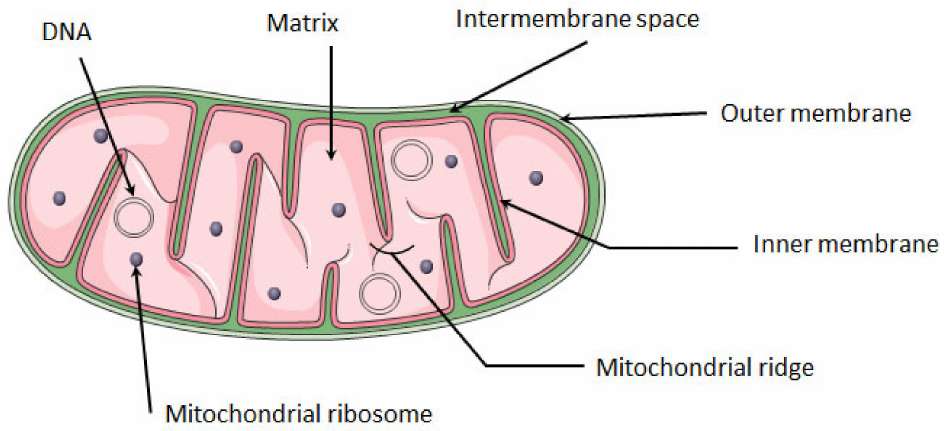
Figure 1. Structure of mitochondria. The mitochondrion is composed of a double membrane: the inner membrane and the outer membrane. Between these membranes is the intra-membrane space. The inner membrane forms invaginations called ridges where the OXPHOS complexes are located. The mitochondrial matrix contains several copies of mitochondrial circular DNA and ribosomes. Mitochondria image adapted from Smart. Available online: https://smart.servier.com (accessed on 10 August